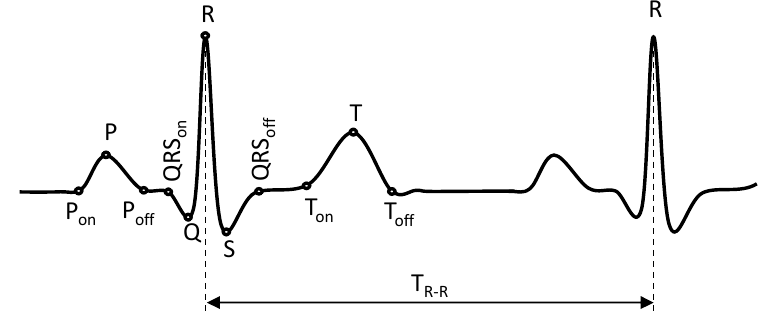
Figure 1. Electrocardiogram (ECG) P-QRS-T complex and fiducial characteristic points.